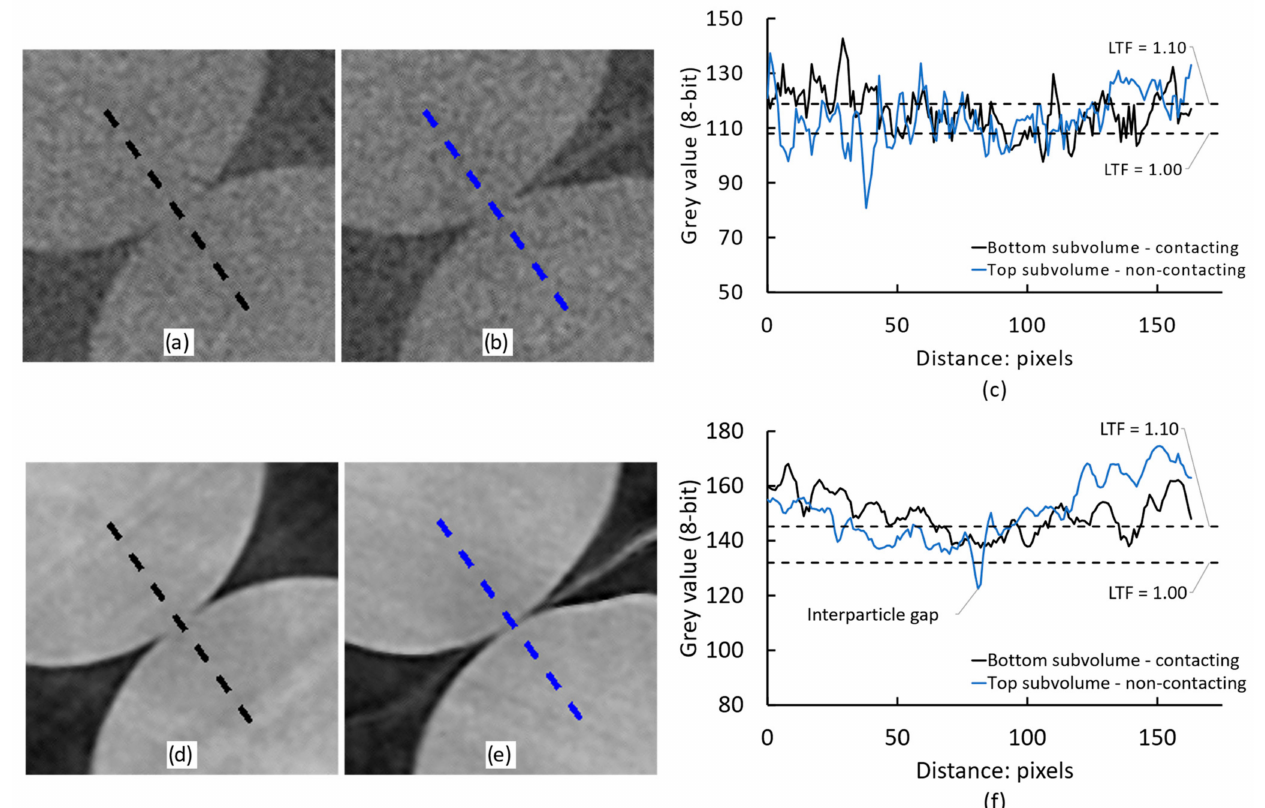
Figure 11. Grey value sampling profiles on horizontal XY slices: ( a ) true interparticle contact in bottom subvolume of scan B3; ( b ) film-separated particles in top subvolume of scan B3; ( c ) grey value profiles sampled from black and blue dotted lines in ( a ) and ( b ), respectively; ( d ) true interparticle contact in bottom subvolume of scan A4; ( e ) film-separated particles in top subvolume of scan A4; ( f ) grey value profiles sampled from black and blue dotted lines in ( d ) and ( e ),